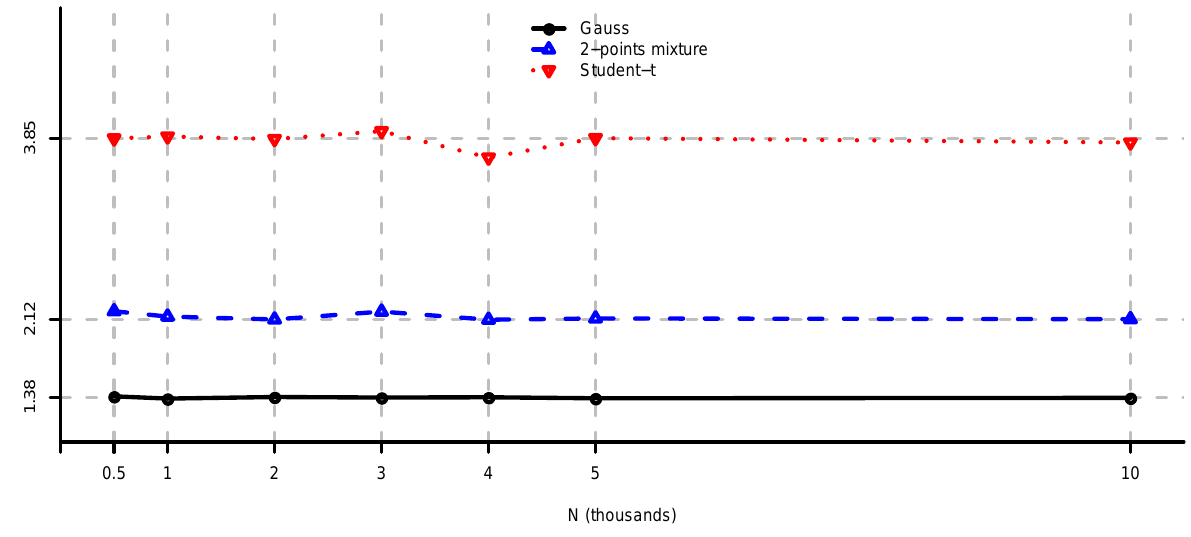
Figure 1. L Gauss ( U mv , ˆ U mv , R n ) , L 2pm ( U mv , ˆ U mv , R n ) and L t ( U mv , ˆ U mv , R n ) computed by simulation for n = 50 , m = 100 and different values of N . The values given by Theorem 2 are approximately 1 . 3814 , 2 . 1236 and 3 . 8453 , respectively.